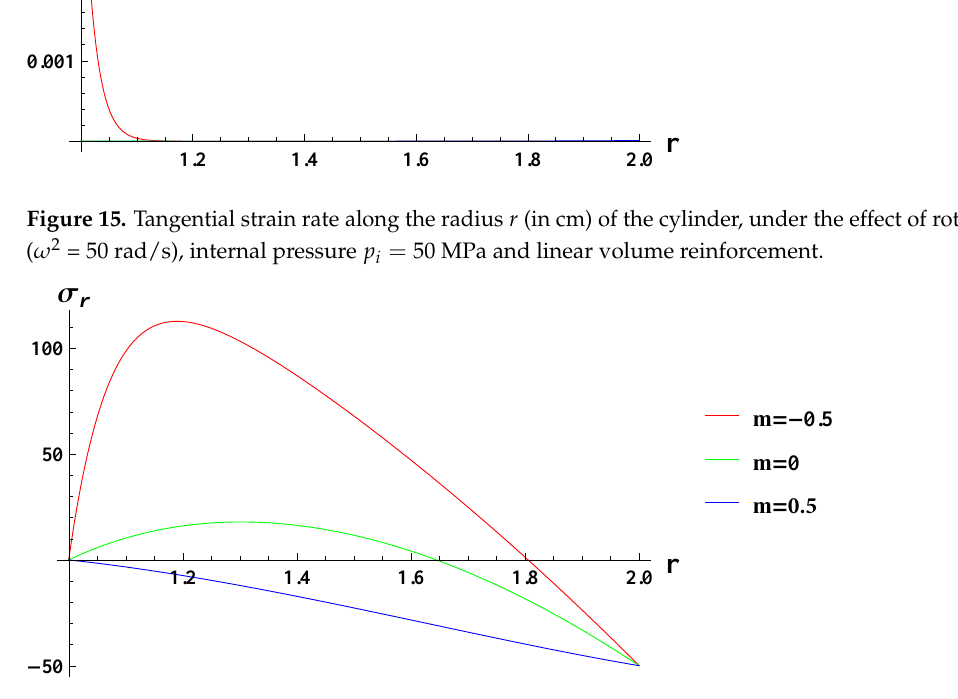
Figure 16. Radial stress (in MPa) along the radius r (in cm) of the cylinder, under the effect of rotation ( ω 2 = 50 rad/s), external pressure p o = 50 MPa and linear volume